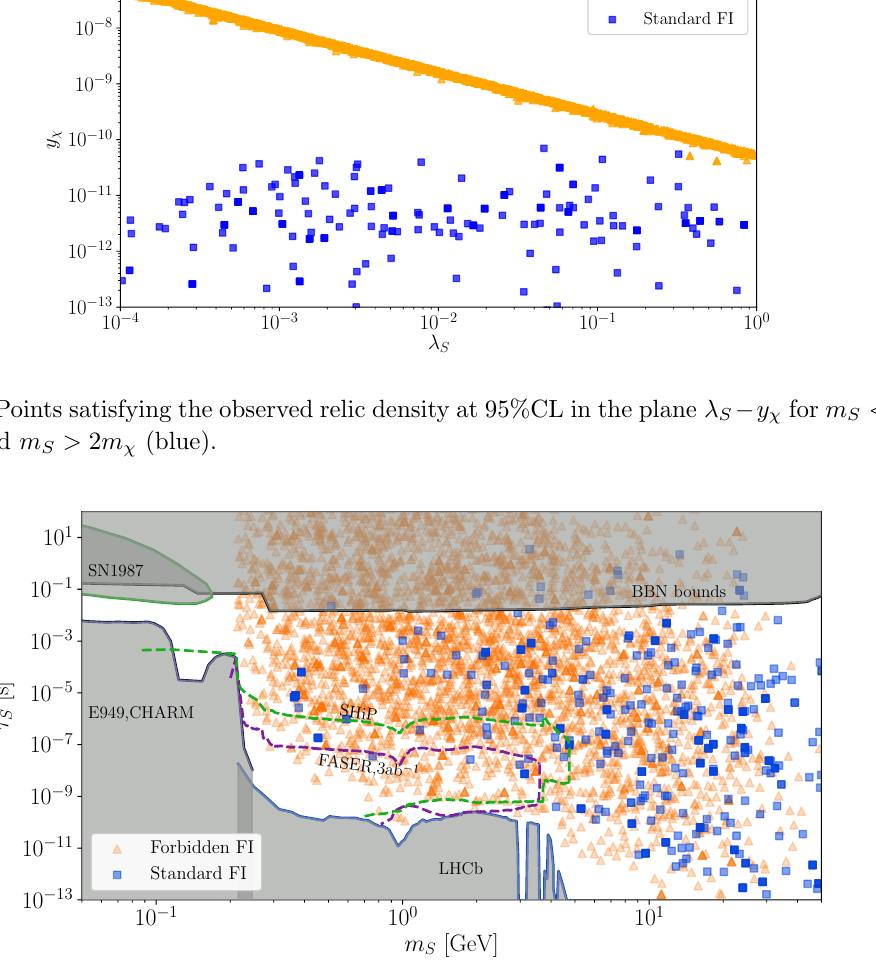
Figure 9. Experimental limits for our model, for points satisfying the observed relic density at 95%CL in the plane m